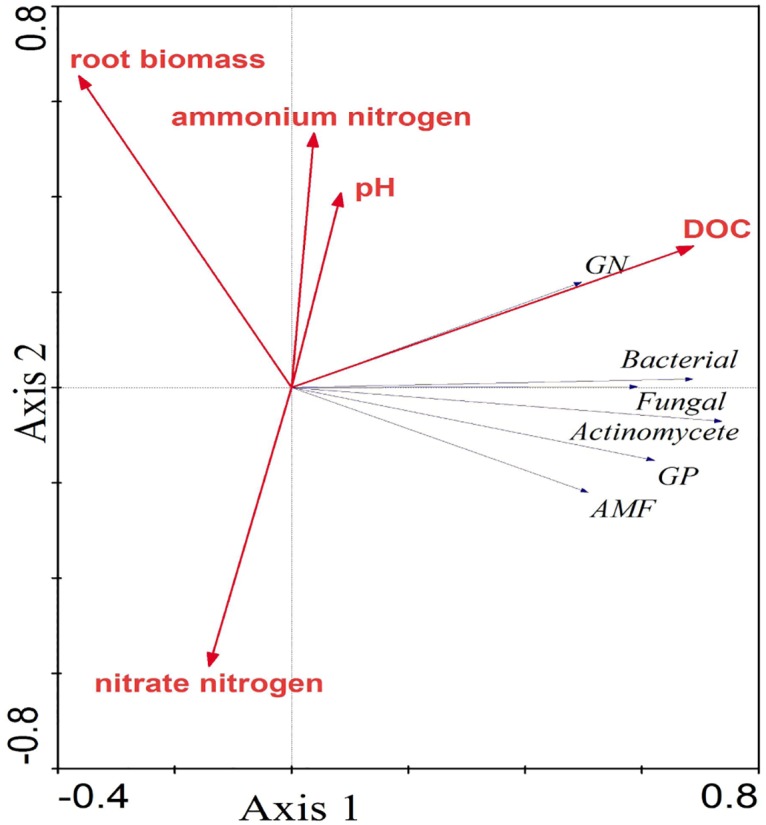
Redundancy Analysis (RDA) of the PLFA data for the 30 soil samples, using 6 PLFAs as species and 6 environmental variables.The arrows indicate the lengths and angles between explanatory and response variables and reflect their correlations. The red lines, blue lines and cycles represent the environmental variables, microbial groups and soil samples, respectively. DOC, dissolved organic carbon, AMF, arbuscular mycorrhizal fungal, GP, gram-positive bacterial, GN, gram-negative bacterial.